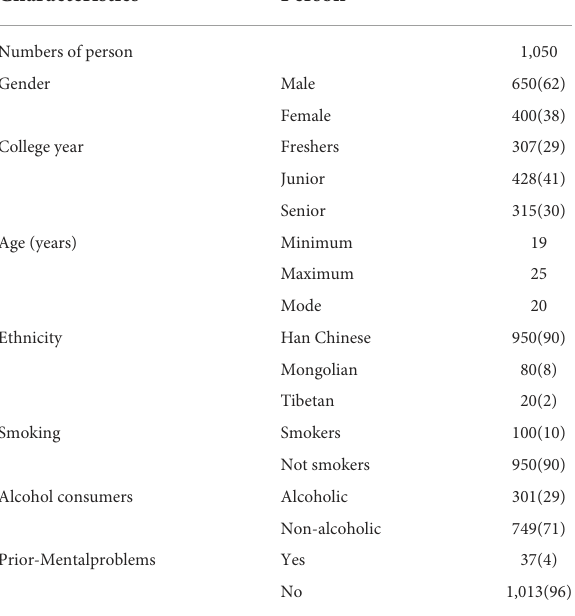
TABLE 1 Characteristics of